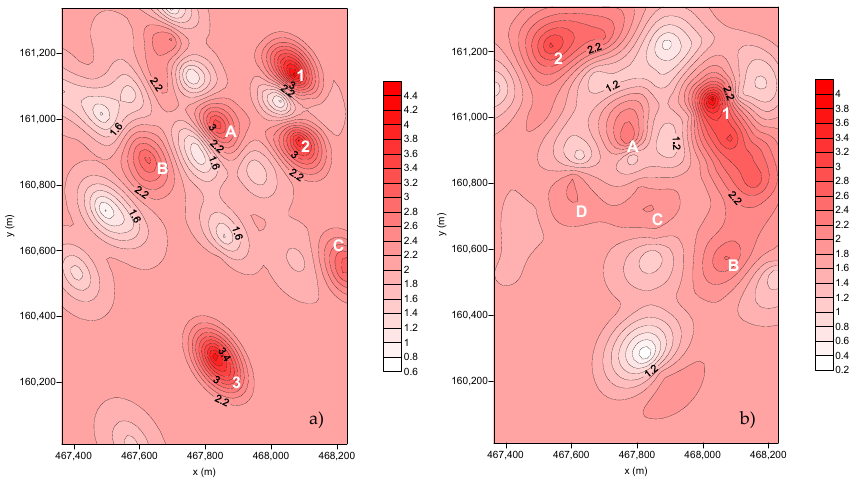
Figure 5. Spatial distribution of the dust flux deposition (g m –2 month –1 ): a) SC2 and b) SC3.